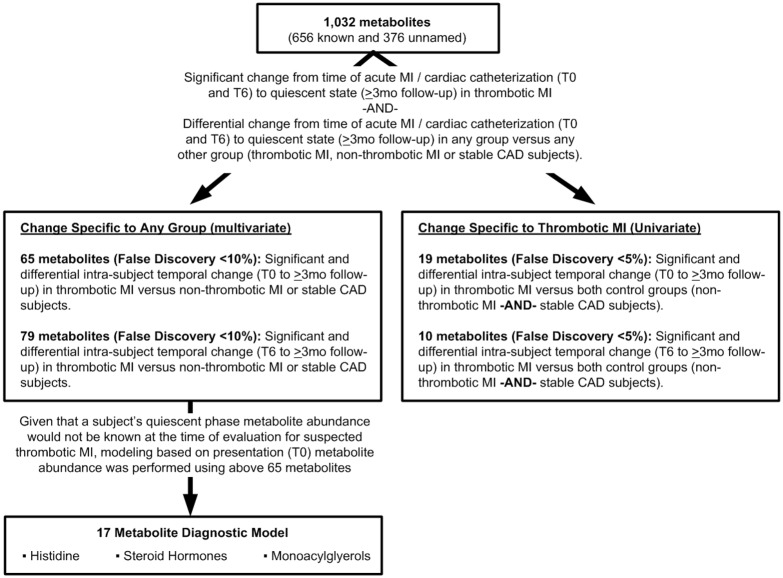
Analytical process.